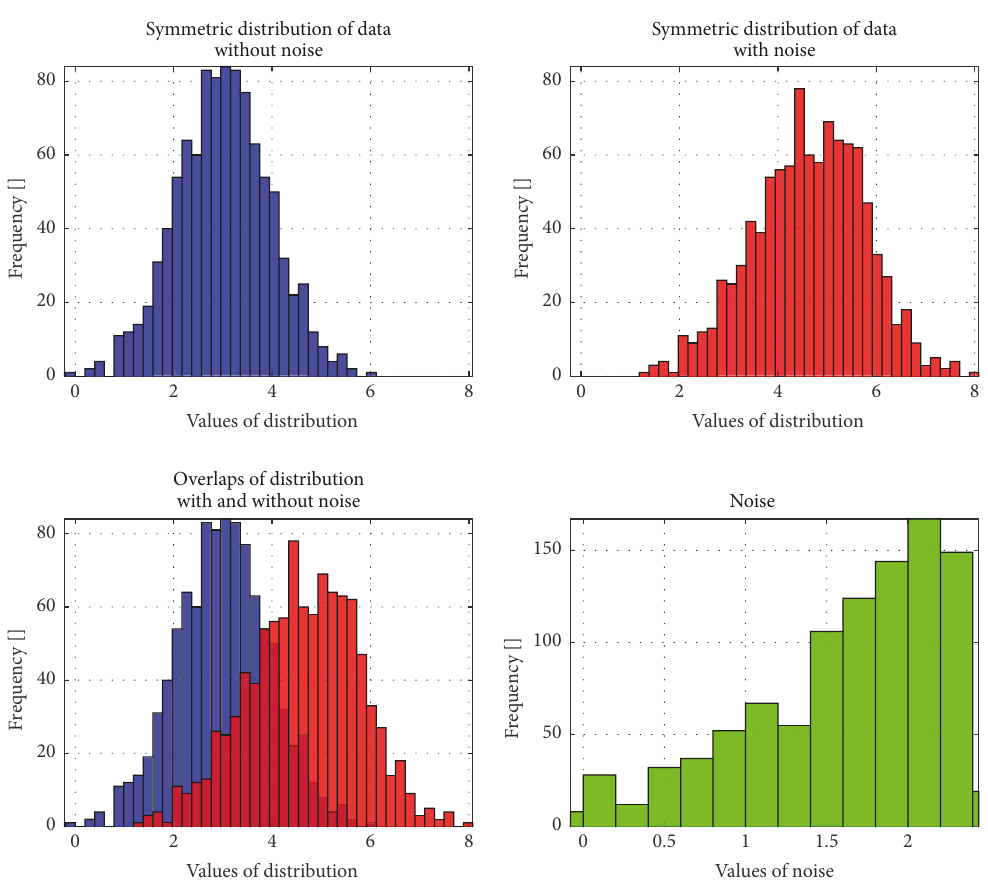
Figure 1: Distribution of data sampled from a Gaussian distribution (of 𝑥 =3 and s =1) affected by Gaussian noise of zero mean and standard deviation basically proportional to the absolute value of the data (see bottom right